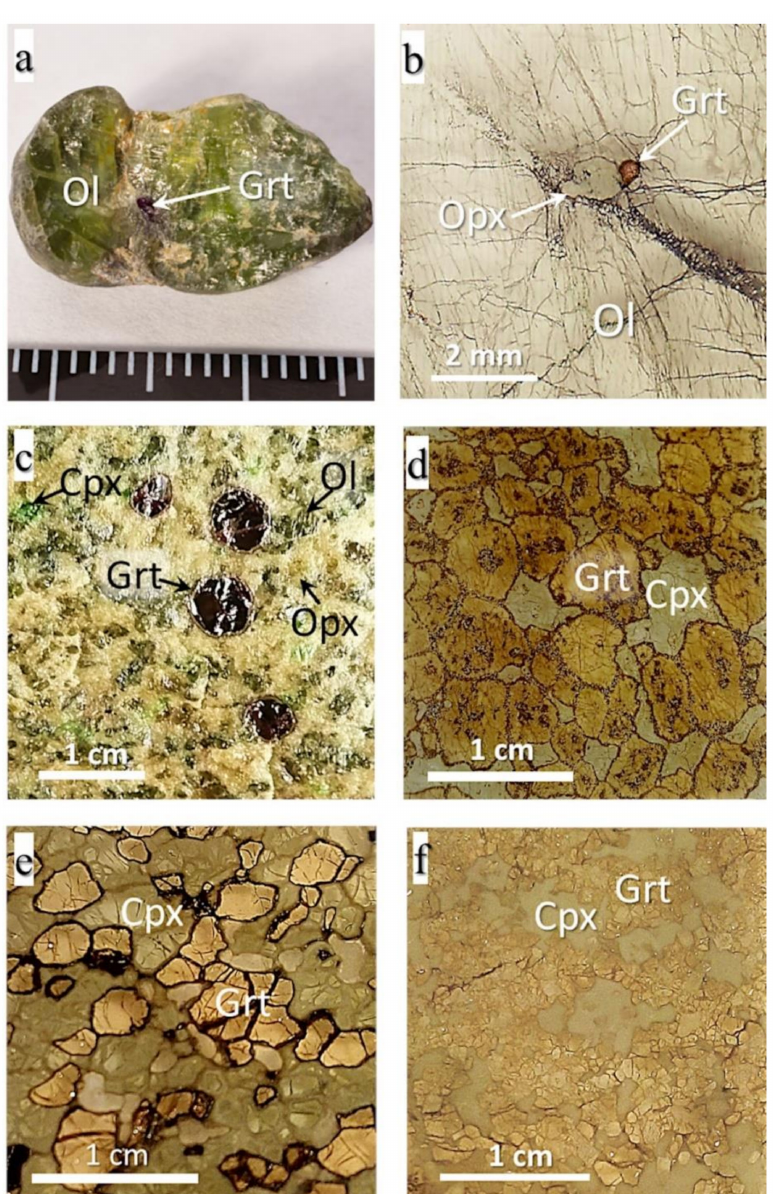
Figure 1. Upper mantle rock xenoliths from Udachnaya kimberlite: ( a ) General view of megacrys- talline dunite; ( b ) fragment of megacrystalline harzburgite; ( c ) fragment of fresh sheared lherzolite; ( d ) typical group A eclogite with equigranular to poikiloblastic texture; ( e ) typical group B eclogite with medium-grained, granoblastic texture; ( f ) group C eclogite with nonequidimensionally grained granoblastic